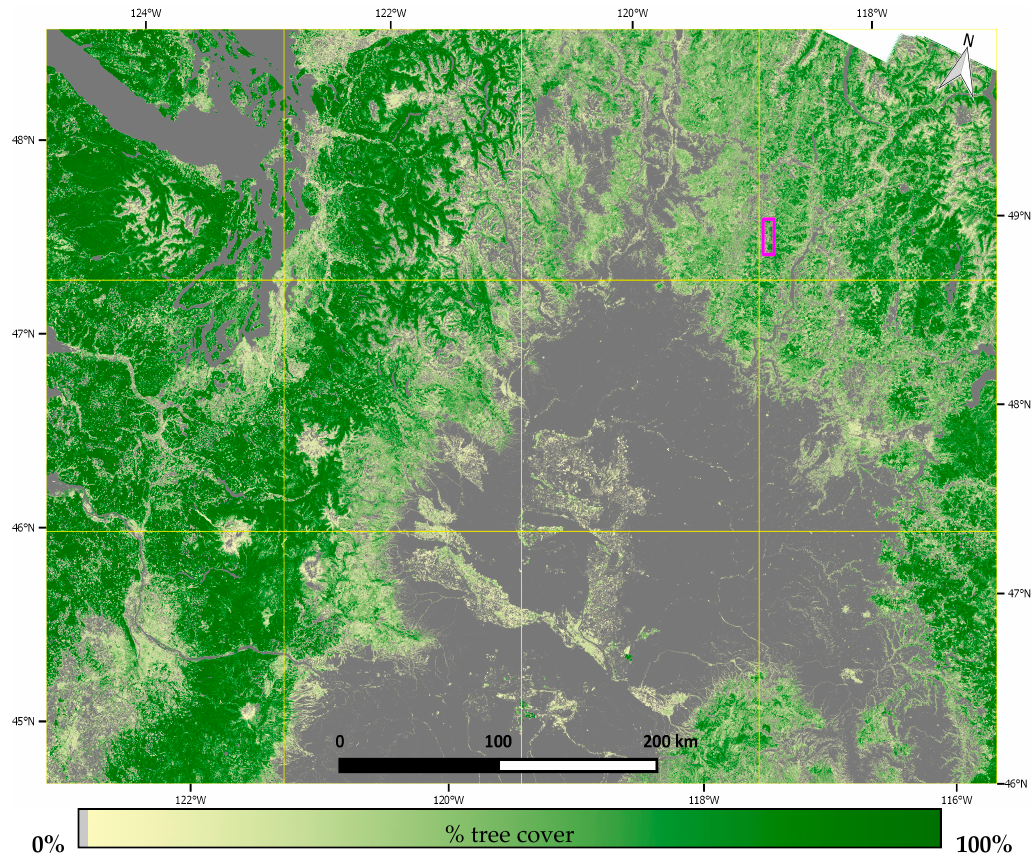
Figure 4. Mapped 30 m percent tree cover for the study area (Figure 1) derived by bagged regression tree estimation using 50 multi-temporal metrics extracted from the atmospherically corrected ARD (SRF ARD) data and 8% G-LiHT training data sampling. The magenta box shows the location of the detailed results illustrated in Figure